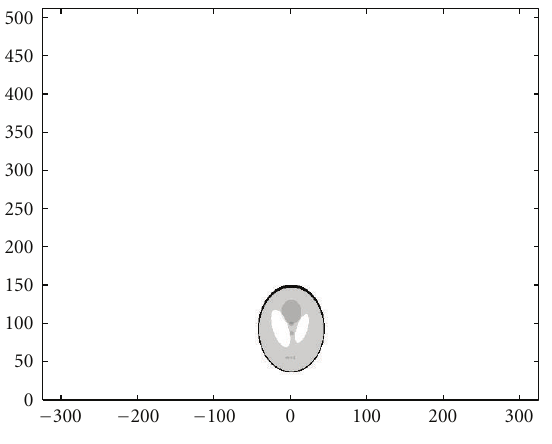
Figure 24: FBP-IM reconstruction of the Shepp-Logan phantom with dω = 0 . 0025